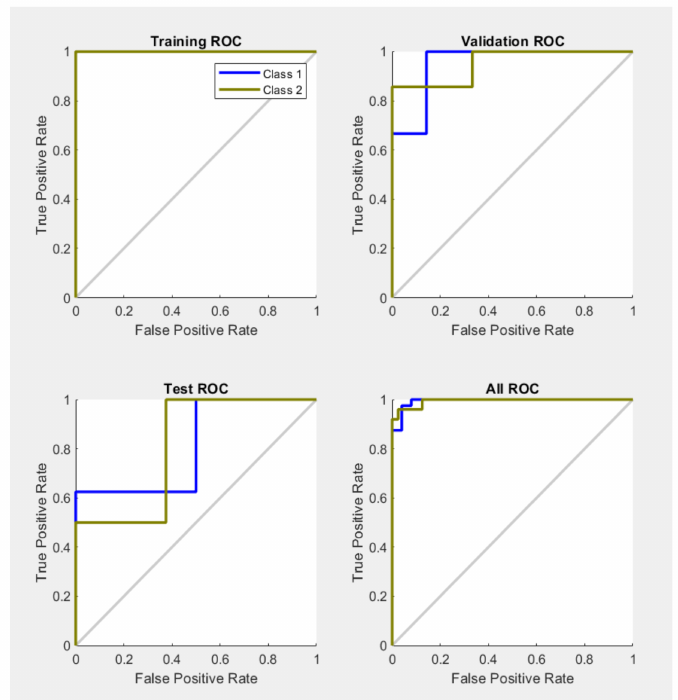
Figure 13. Neural network training, testing and validation states ROC plot.